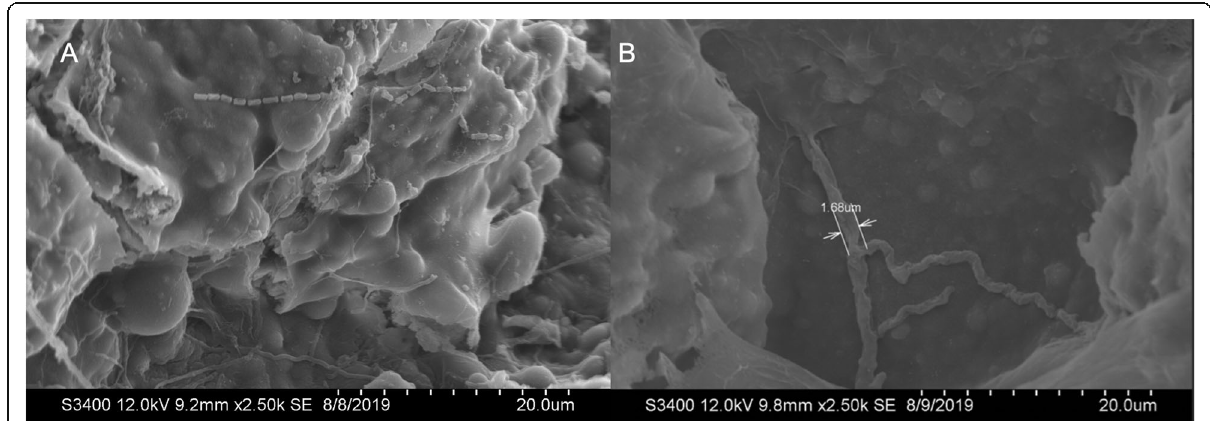
Fig. 1 A Scanning electron microscope images of rod-shaped bacteria and fungal hyphae on S. virgatus eggshells. B Fungal hyphae cover the